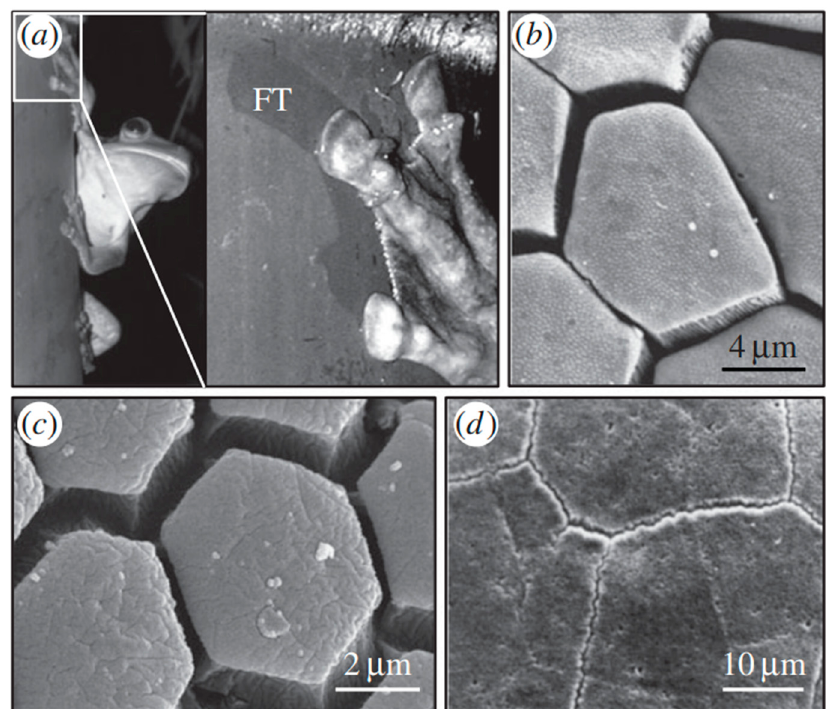
Figure 2. ( a ) On a tree trunk, a rusted tree frog. Due to the limb sliding before friction stopped the action, fluid secretion traces were left on the surface of the tree (FT), and the surface pattern was obtained in ( b ) tree frog, ( c ) bush cricket, and ( d ) mushroom-tongued salamander [89]. Copyright Permission 2014, Royal Society.